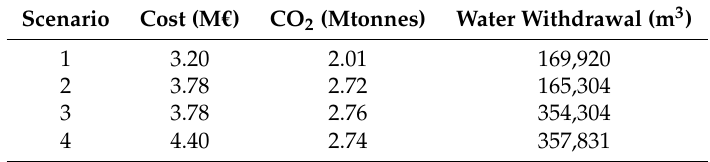
Table 6. Cross comparison of cost, CO 2 emissions and water withdrawal in each scenario.